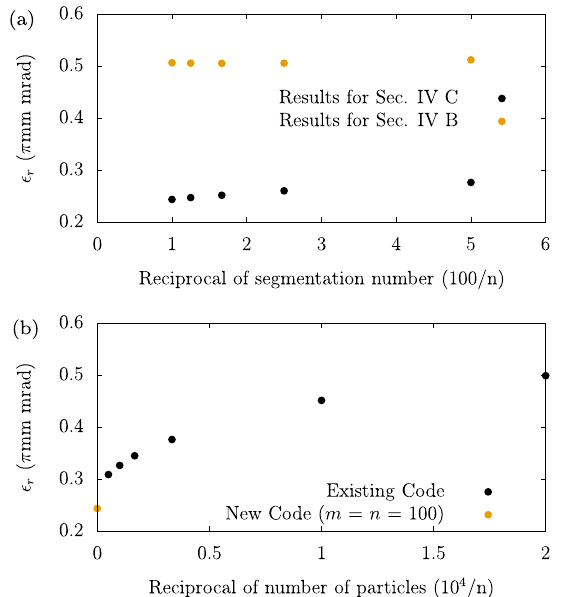
16. Emittance dependence on numbers of particles and segmentations. (a) Emittance dependence on segmentation number in the new code. m and n are the same in each calculation. m ¼ n ¼ 20 for the rightmost points and m ¼ n ¼ 100 for the leftmost points. (b) Emittance dependence on numbers of particles used in the existing code. The number of particles is 5 × 10 3 for the rightmost point and 2 × 10 5 for the leftmost black point. A result calculated by the new code whose segmentation numbers are m ¼ n ¼ 100 is plotted as a color